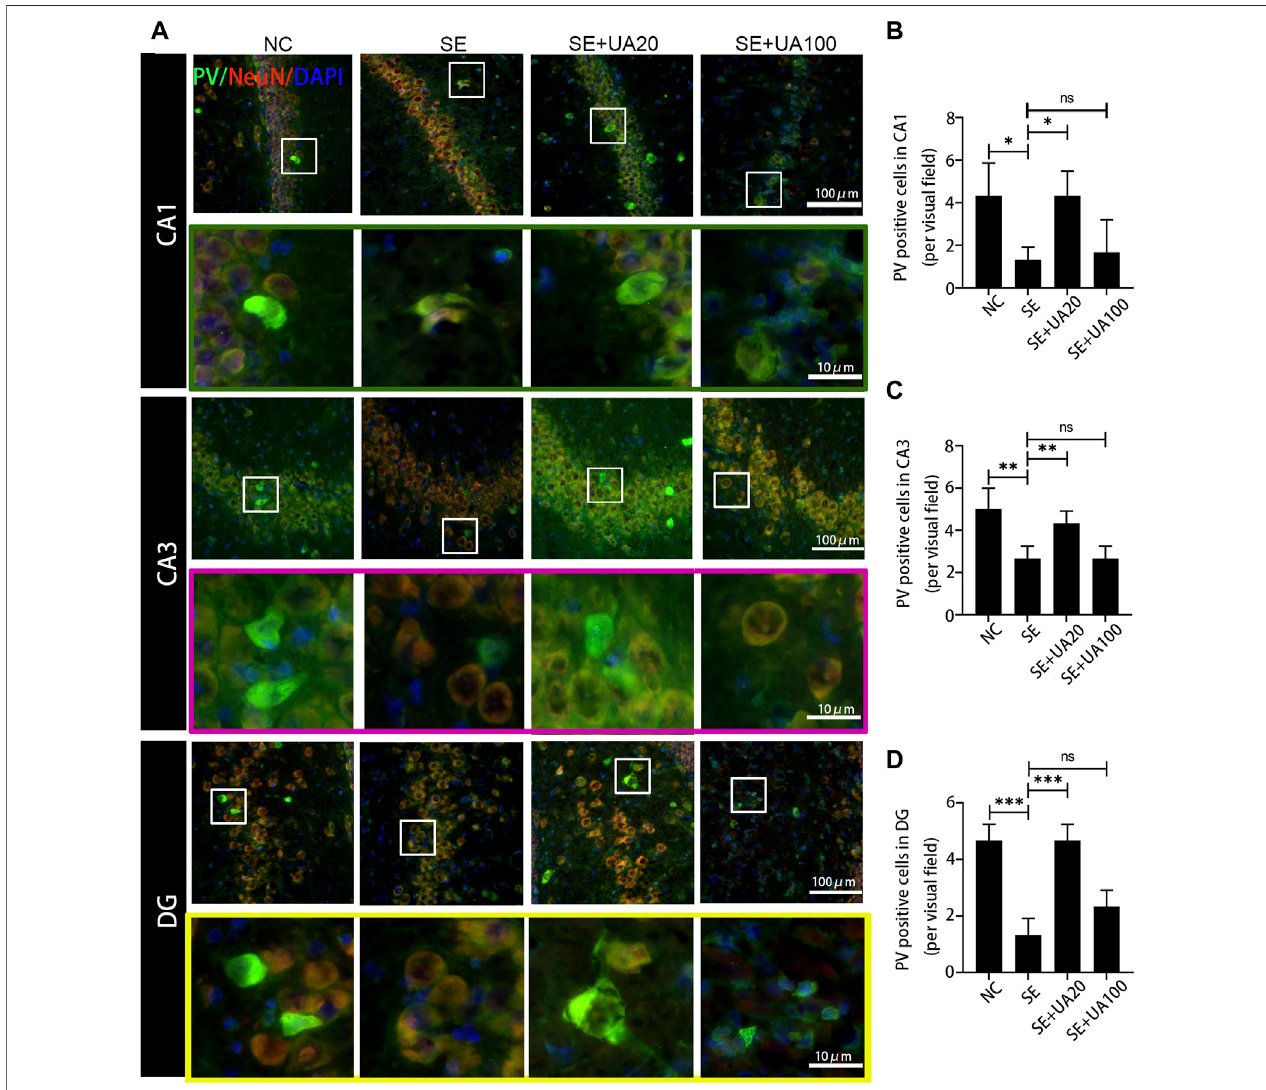
FIGURE 8 | UA promoted the PV expression after SE induction. (A) Immuno fl uorescent triple-staining of PV (green), NeuN (red), and DAPI (blue) in the CA1, CA3, and DG regions of rat hippocampus. (B – D) The number of PV + cells in each region of the hippocampus after SE induction. (three rats per group, all values were expressed as means ±SD, ppp p < 0.001, pp p < 0.01, p p < 0.05 vs . SE, one-way